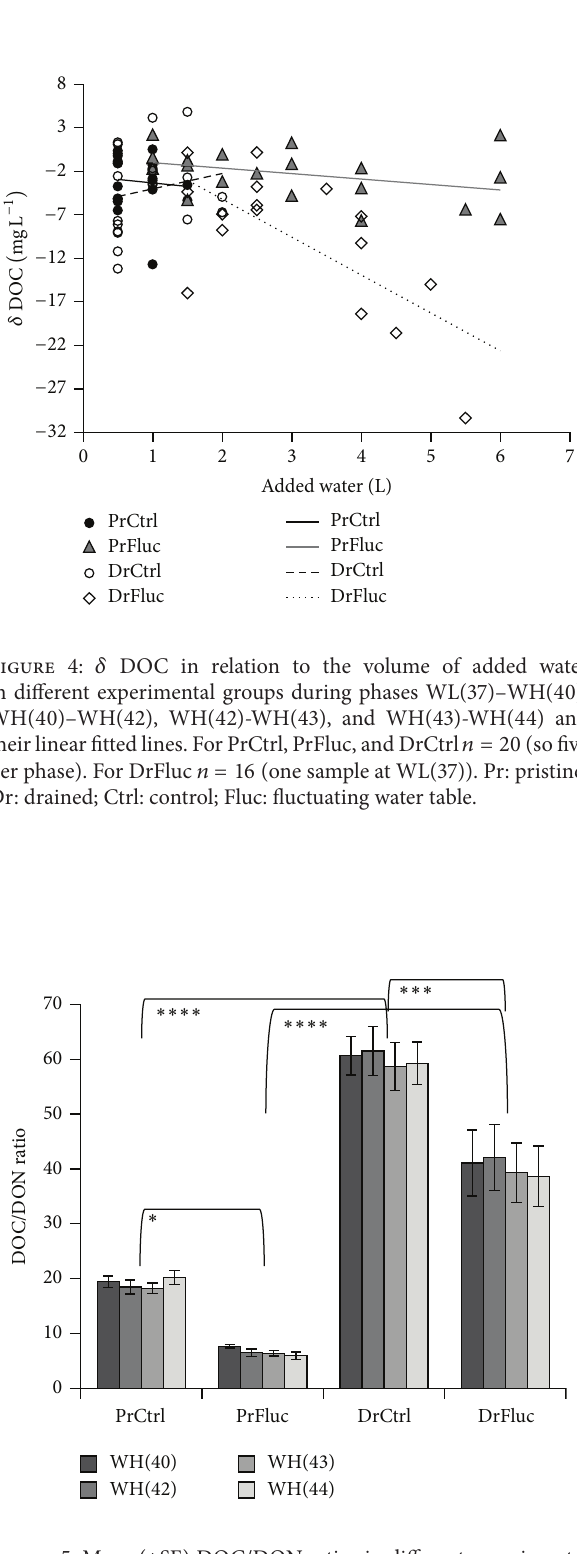
Figure 5: Mean ( ± SE) DOC/DON ratios in different experimental groups at different phases of the study. 𝑁 = 5 for each experimental group and each phase except for DrCtrl at phases WH(43) and WH(44), where 𝑛 = 4 . Significant differences between the experi- mental groups are indicated with asterisks ( ∗ 𝑃 < 0.05 ; ∗∗∗ 𝑃 < 0.001 ; ∗∗∗∗ 𝑃 < 0.0001 ). W: water sampling; H: high water table; (xx): calendar week number. Pr: pristine; Dr: drained; Ctrl: control; Fluc: fluctuating water